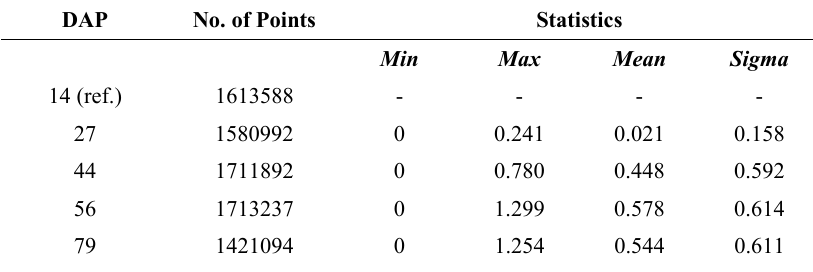
Table 2. Statistical parameters of the deviation point clouds in m using DAP 14 as